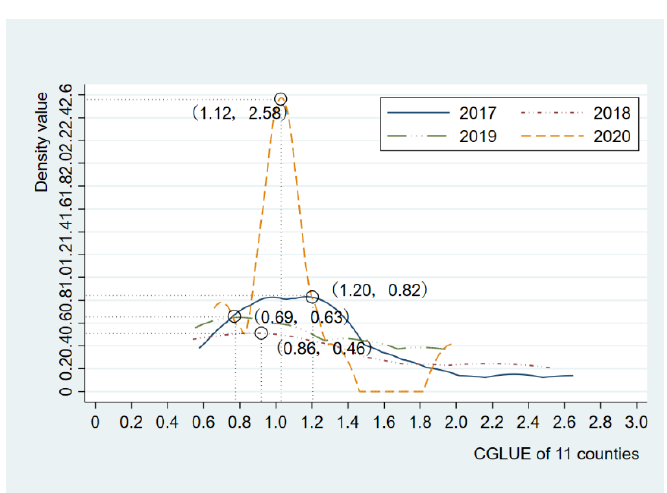
Figure 9. Efficiency kernel density curve from 2013 to 2016.